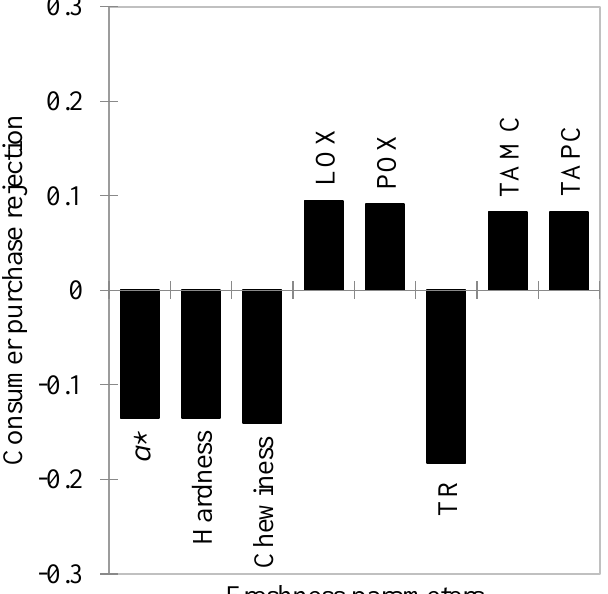
Figure 5. Weighted regression coefficients of cluster 2 for freshness parameters of Nile tilapia ( Oreochromis niloticus ) fillets stored at 4 ± 1 ◦ C for 8 days by partial least square regression (PLSR). X axis = freshness parameters; Y axis = consumer purchase rejection (CPR). a *—redness; LOX—lipid oxidation; POX—protein oxidation; TR—torrymeter readings; TAMC—total aerobic mesophilic count; TAPC—total aerobic psychrotrophic count.